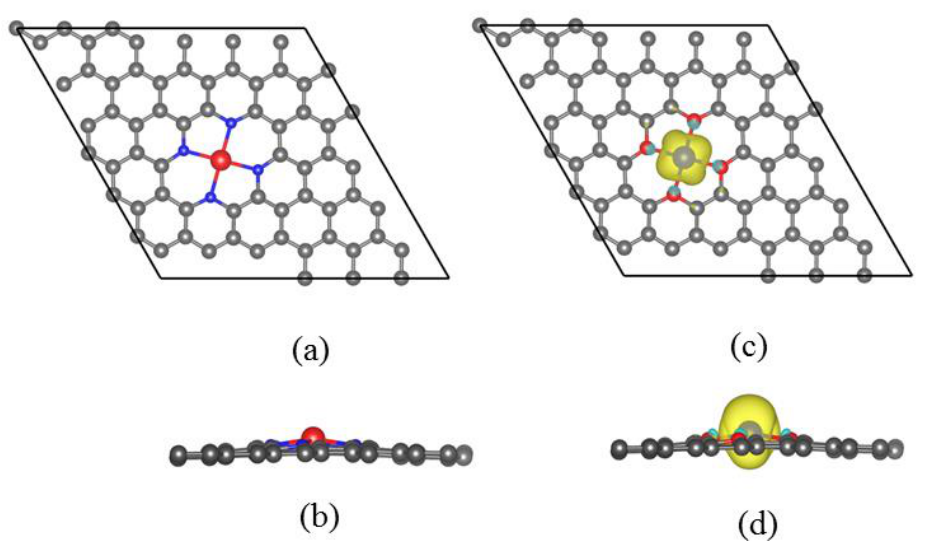
Figure 1. ( a , b ) Structure diagrams of Re@NDV; ( c , d ) spin density diagrams of Re@NDV. In Figures ( a , b ), blue and red represent N atoms and Re atoms, respectively. In Figures ( c , d ), yellow represents spin-up charge density, cyan represents spin-down charge density, and red represents N atoms. ( a , c ) Top view; ( b , d ) side view.